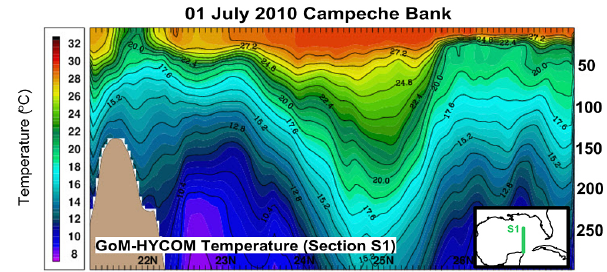
Figure 10. Campeche Bank temperature ( ◦ C) along the S1 vertical section (GoM insert: green line) on 1 July